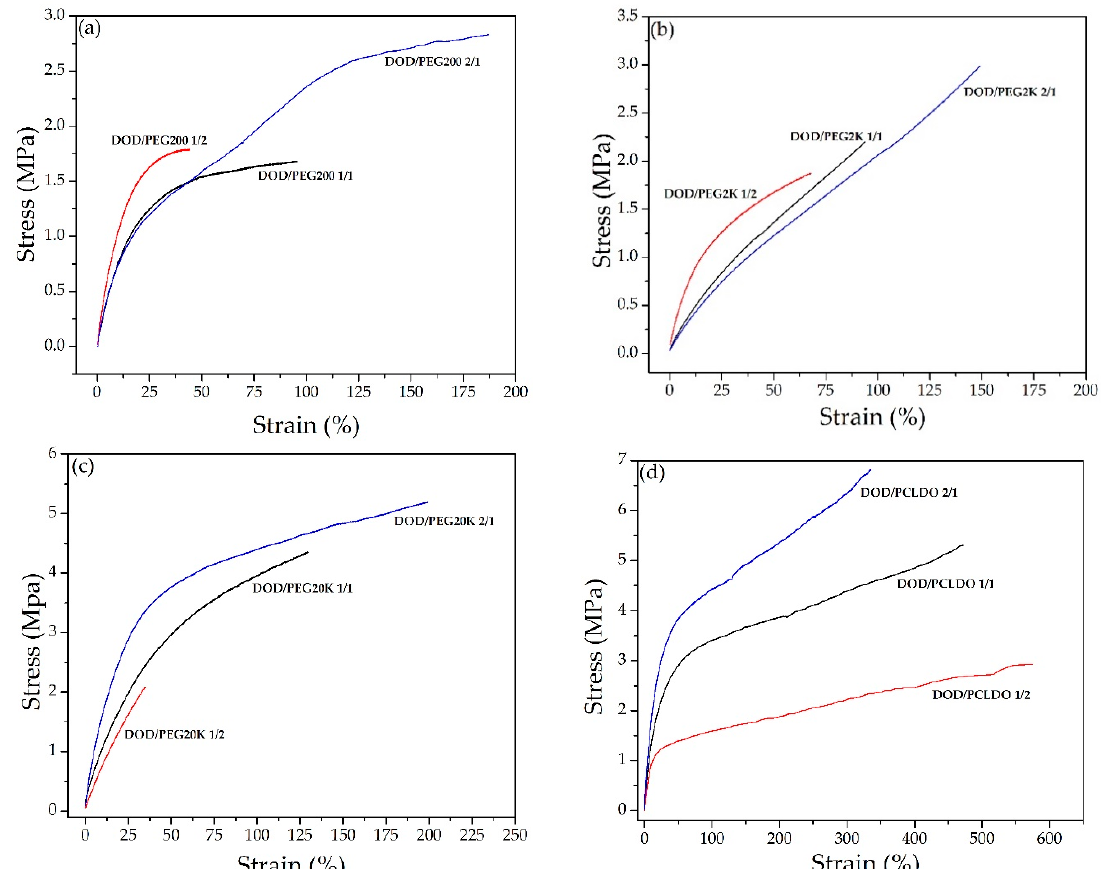
Figure 10. Stress-strain curves of ( a ) PU-DOD/PEG200, ( b ) PU-DOD/PEG2K, ( c ) PU-DOD/PEG20K, and ( d ) PU-DOD/PCLDO.